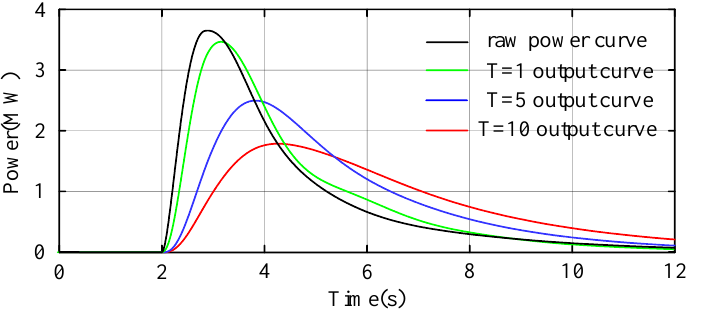
Figure 7. Comparison of power command filtering effect under different time constants.